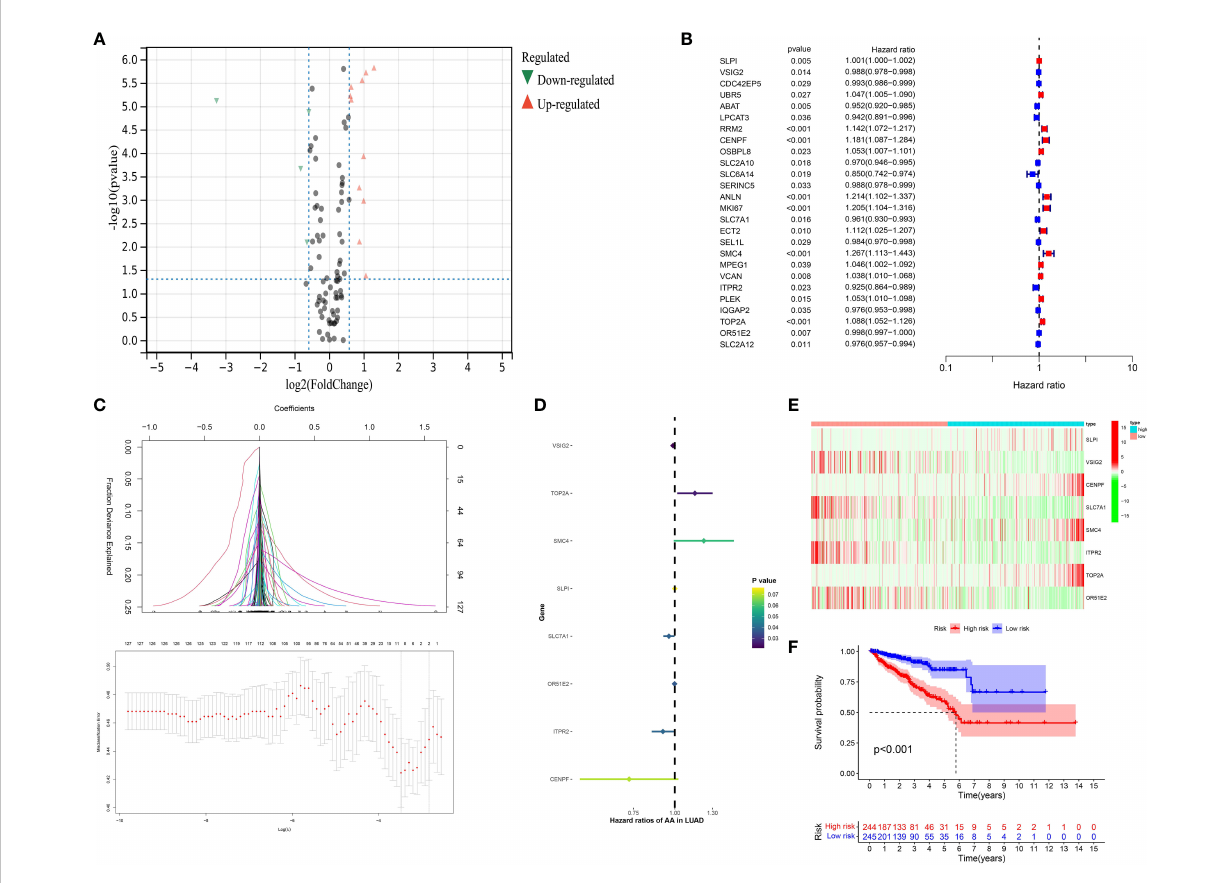
FIGURE 4 (A) The results of the differentially expressed analysis between normal cohort and prostate cancer patients; (B) The results of the univariate COX regression analysis; (C) The results of the lasso regression analysis based on the prognostic-related genes; (D) The results of the multivariate COX regression analysis; (E) The heatmap reveals the different group based on the risk score; (F) The survival analysis between low- and high-CAFs